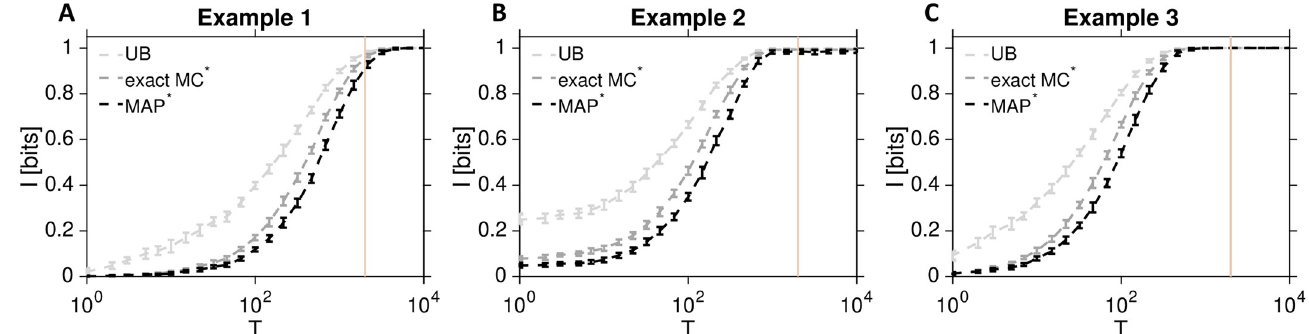
Fig 3. Information about inputs encoded by complete response trajectories of the example biochemical reaction networks. Exact Monte Carlo approximation for the information, I � ð X ; U Þ , is shown for Example 1 (A) , Example 2 (B) , and Example 3 (C) from Fig 2 in dashed dark gray line; error bars are standard exact deviations across 20 replicate estimations, each computed over N = 1000 independently generated sample trajectories per input condition. Information is plotted as a function of the trajectory duration, T ; yellow vertical line indicates T = 2000 as a representative duration used in further analyses below, at which most of the information about input is in principle available from the response trajectories of our systems. I � ð ^ U ; U Þ (dashed black line) is the optimal decoding lower bound, MAP (dashed light gray) is the upper bound on the information, computed by applying Eq (29). and I � UB